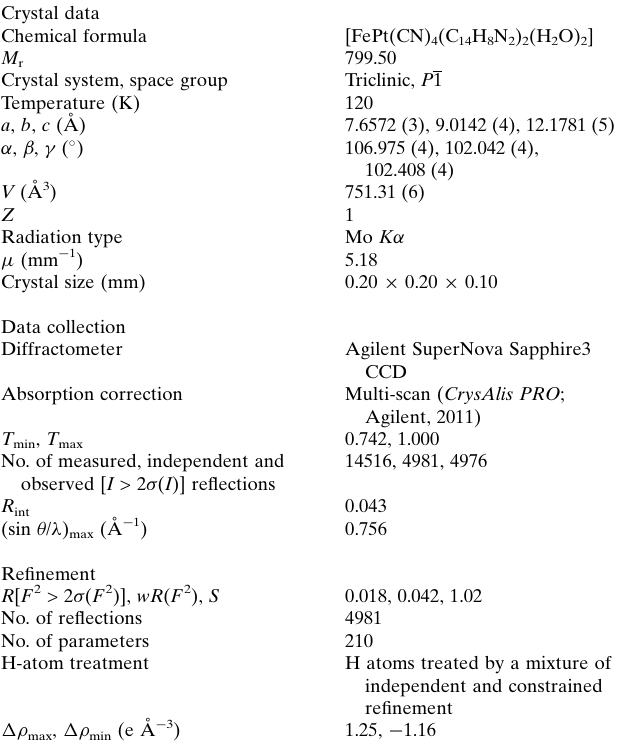
Crystal data Chemical